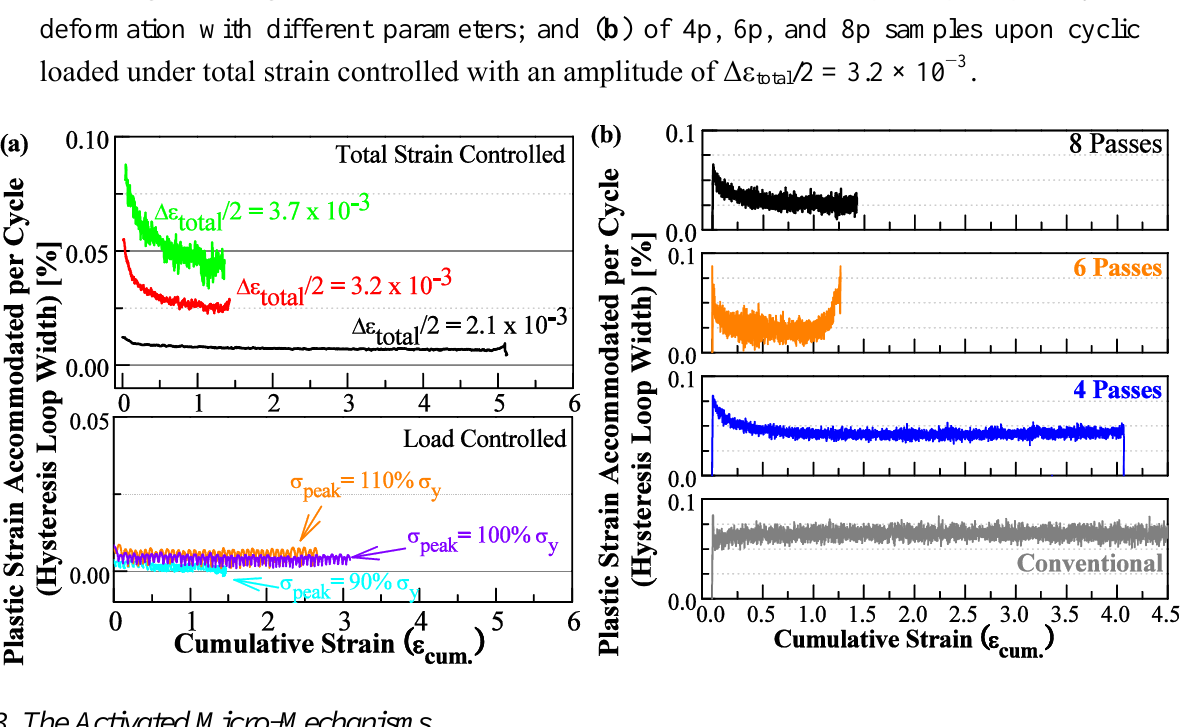
Figure 3. Plots of the trend of hysteresis loop width representing the cyclic hardening/softening behavior of ARBed CP aluminum of ( a ) an 8p sample upon cyclic deformation with different parameters; and ( b ) of 4p, 6p, and 8p samples upon cyclic loaded under total strain controlled with an amplitude of Δε